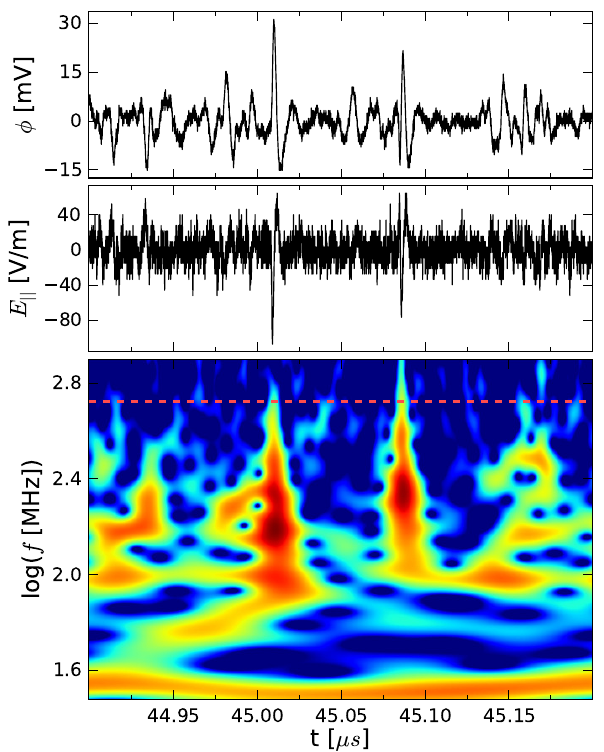
Fig. 1. Potential (top panel) and electric field (middle) displaying isolated structures and electric field wavelet spectrum (bottom). The horizontal dashed on the lower panel shows the electron plasma frequency. Wavelet coefficients are shown on a logarithmic scale.